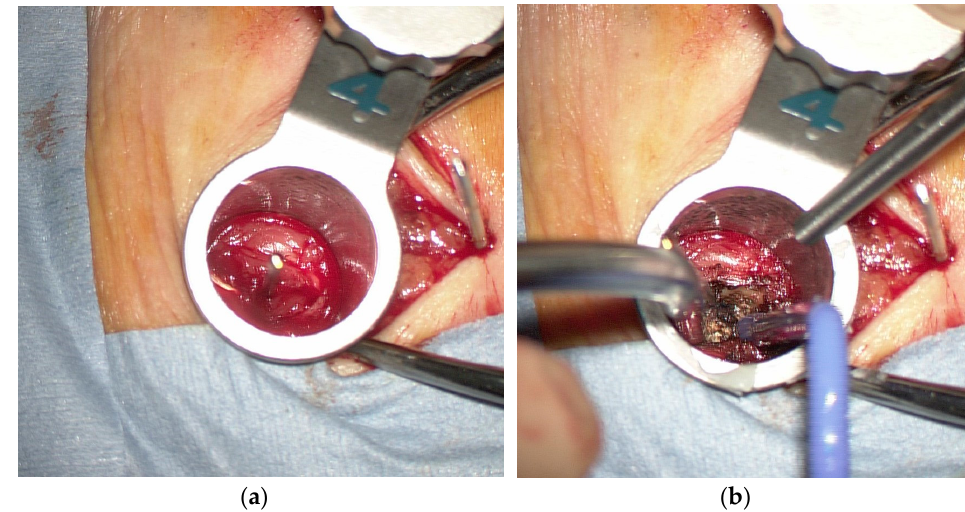
Figure 3. ( a ) A tubular retractor placed over the outside of the facet joint along the K-wire; ( b ) exposure of the lateral margin of the facet joint.